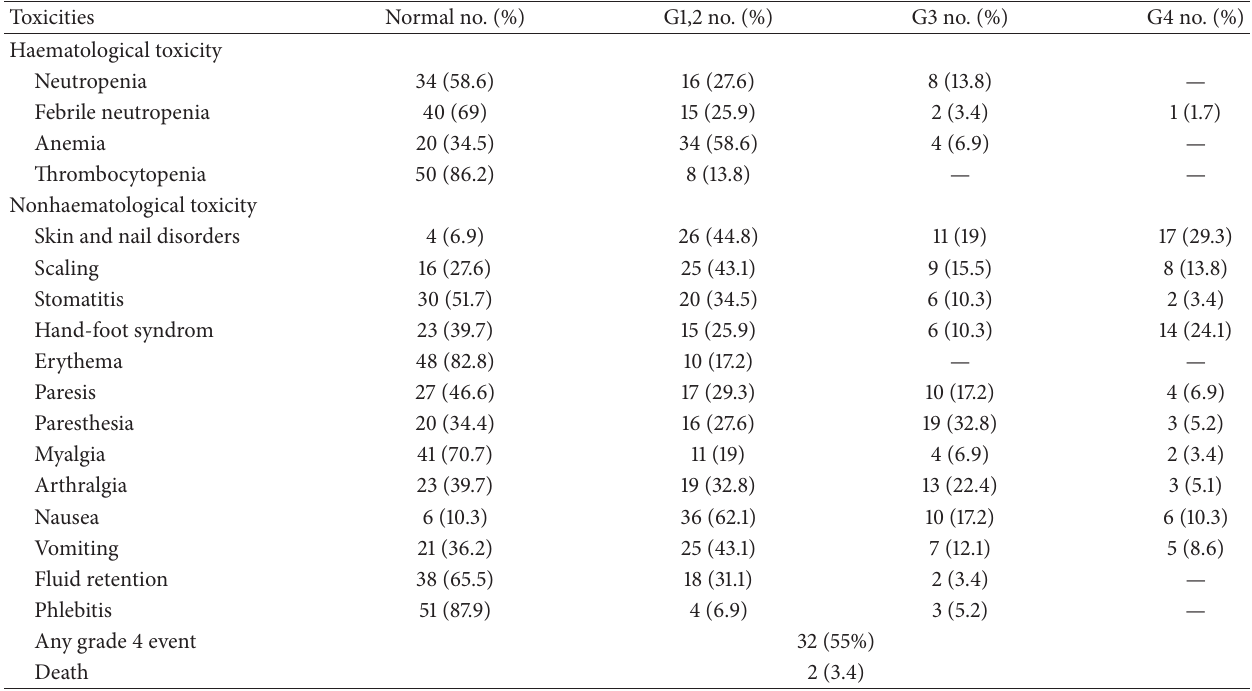
Table 2: Incidence of toxicities in treated